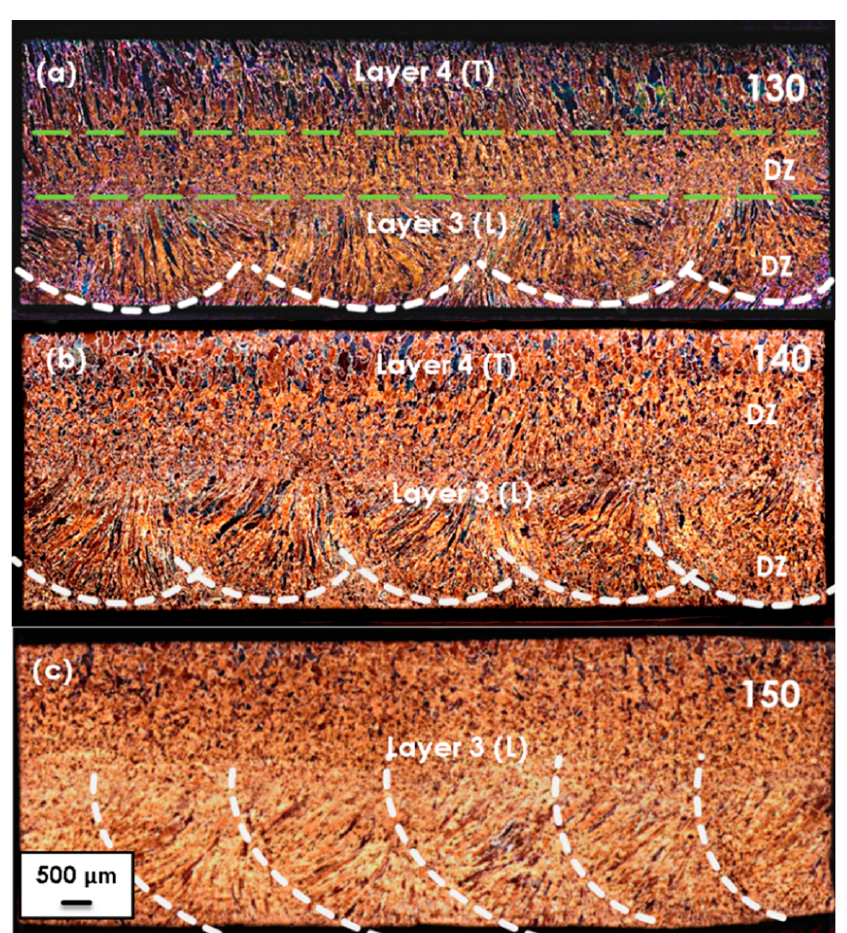
Figure 11. OM panoramic images for the prismatic blocks deposited at constant BW of (5 mm) and OPs of: ( a ) 30%; ( b ) 40%; ( c ) 50%. Diffusion zone—DZ, longitudinal layer—L, transverse layer—T. According to Ghaffari et al. [21], there are four microstructural zones formed within the adjacent beads within each deposited layer in the WAAM ER70S-6. The zones are the melt pool center (equiaxed grains), the melt pool boundary, and two heat-affected zones (HAZ). The size and coexistence of those distinct zones along with the microstructural phases depend on the deposition strategy, i.e., the directionality of the deposited beads and the investigated samples. Therefore, those zones should be clear in the longitudinal layers rather than in the transverse ones. In addition, the heat input, OP, interpass tempera- ture, thermal cycles, and the cooling rates are expected to have a strong influence on the morphology and types of phases formed within the four zones. This explains the variation in the developed microstructure of the built block in the current work compared to those described by Ghaffari et al. [21]. Investigation of the microstructure of the built blocks within the melt pool center, representing the diffusion zone (DZ) within the substrate (Figure 11), reveals the formation of directionally solidified columnar grains growing along the building direction where there is a decreasing temperature gradient. A relatively high degree of turbulence in the melt pool zone resulted in a nonuniform orientation of the columnar grains within the overlapping zone between the two adjacent beads. This can be attributed to the influence of reheating cycles, which increased with the increase in the bead’s OP. Finer equiaxed grains formed with the DZ between the L and T layers. This is clarified in Figure 11a for